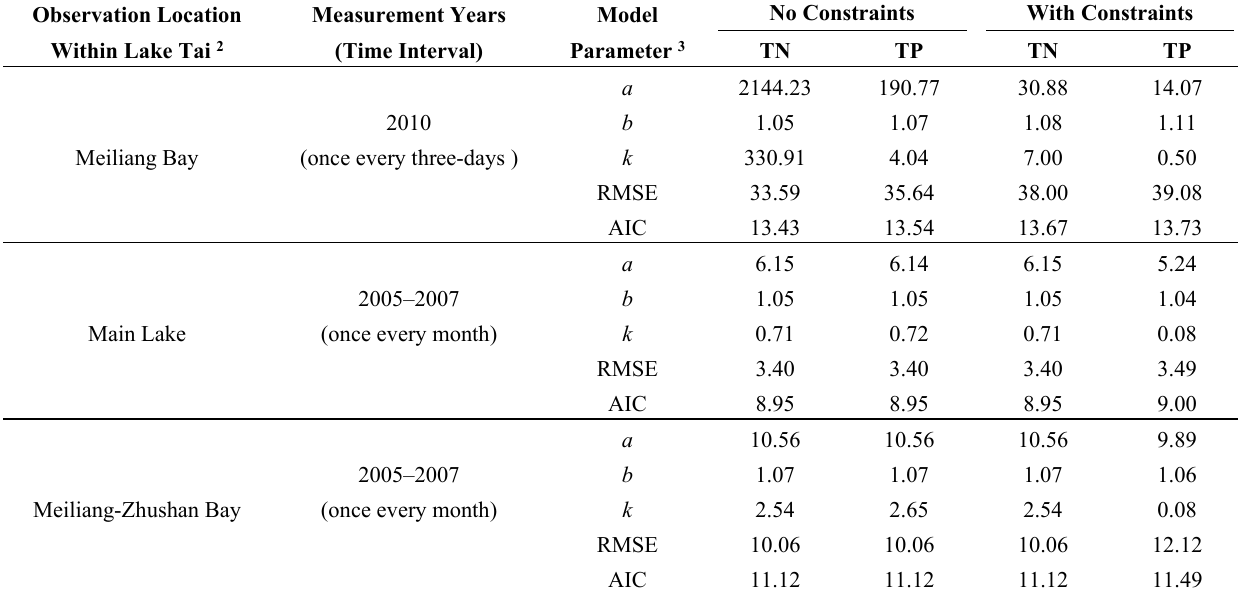
Figure 4. Observed and predicted Chlorophyll a (Chl-a) concentrations for: ( a , b ) Meiliang Bay, three-day measurement intervals; ( c , d ) main lake, monthly measurement intervals; and ( e , f ) Meiliang-Zhushan Bay, monthly measurement intervals. The independent variables are total phosphorus (TP) and temperature. Table 1. The modified Monod model parameters determined by minimizing the root mean square errors (RMSEs) and akaike information criterion (AIC) without and with constraints on the ranges of the parameters 1